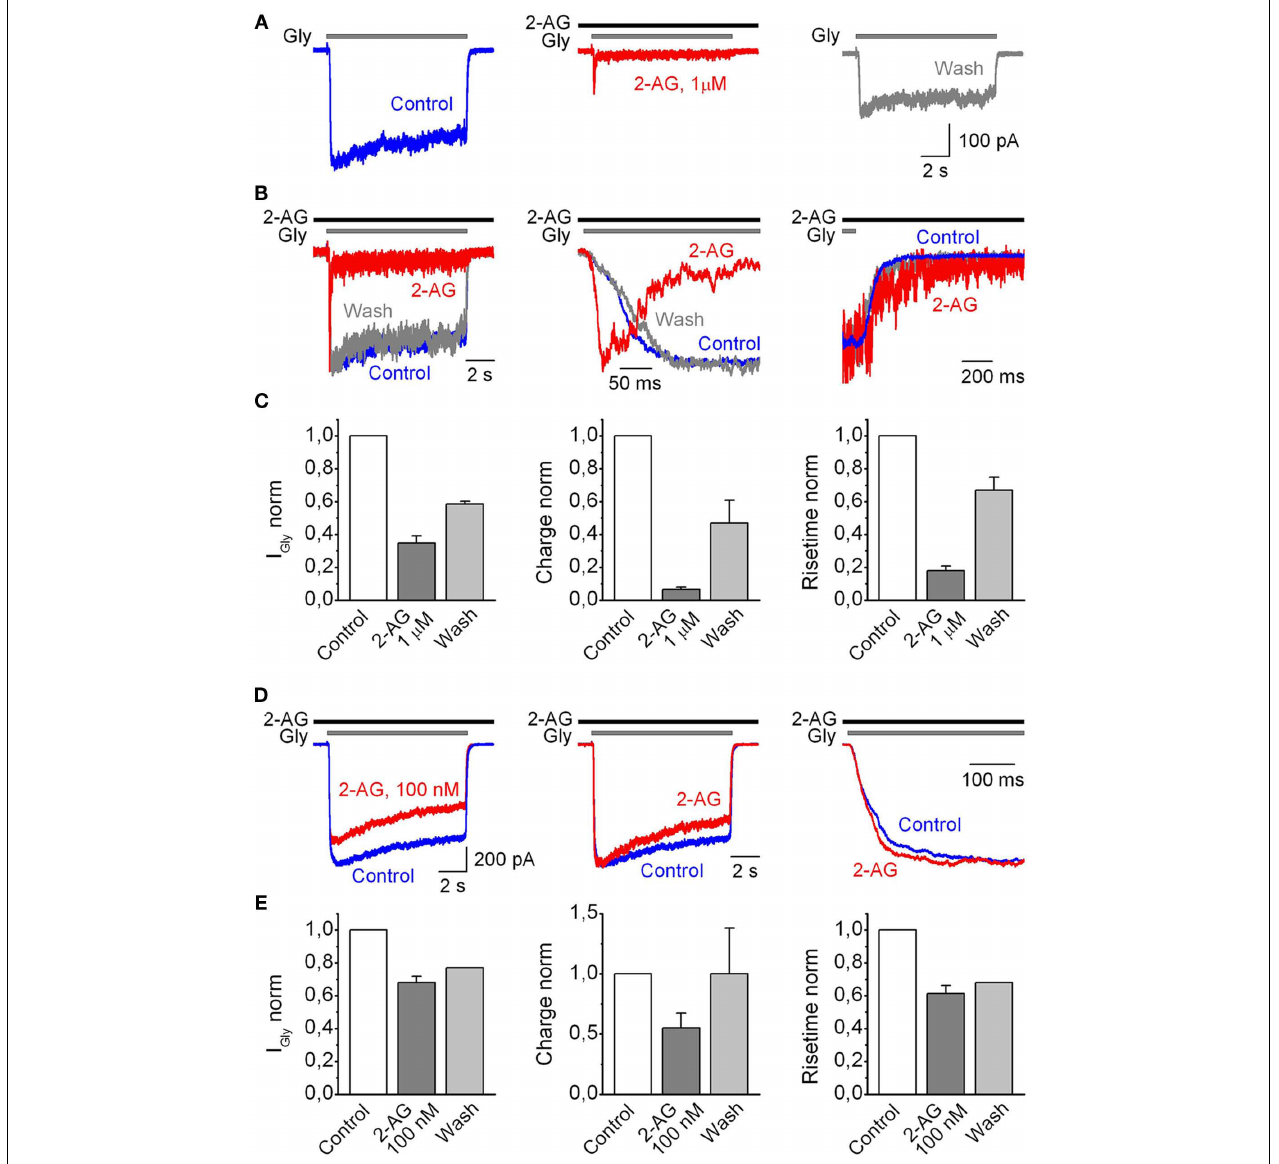
control values. Data from nine outside-out patches. (D) Modulation of I Gly induced by 50 μ M Gly by a submicromolar (100nM) concentration of 2-AG. ( Left ) Representative traces obtained in control (blue) and at 100nM of 2-AG (red). ( Middle ) Corresponding traces are normalized and superimposed. ( Right )The same traces at expanded time scale to illustrate 2-AG-induced changes in the rise time. (E) Summary plots showing the effects of 100nM of 2-AG on the amplitude ( left ), normalized charge ( middle ), and 10–90% rise time of I Gly ( right ), normalized to control values. Data from five outside-out